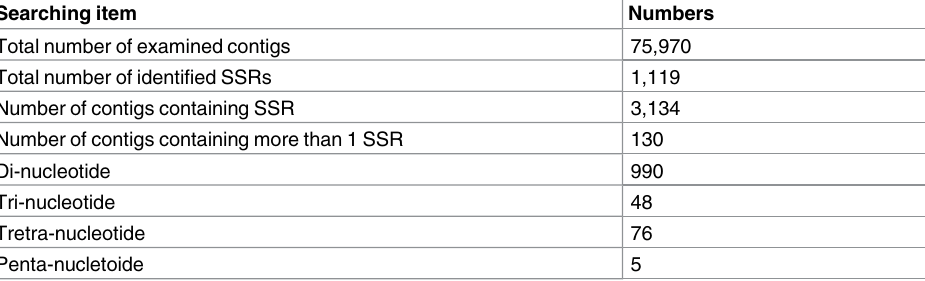
Table 6. Summary of SSRs identified from the sea trout skin transcriptome.